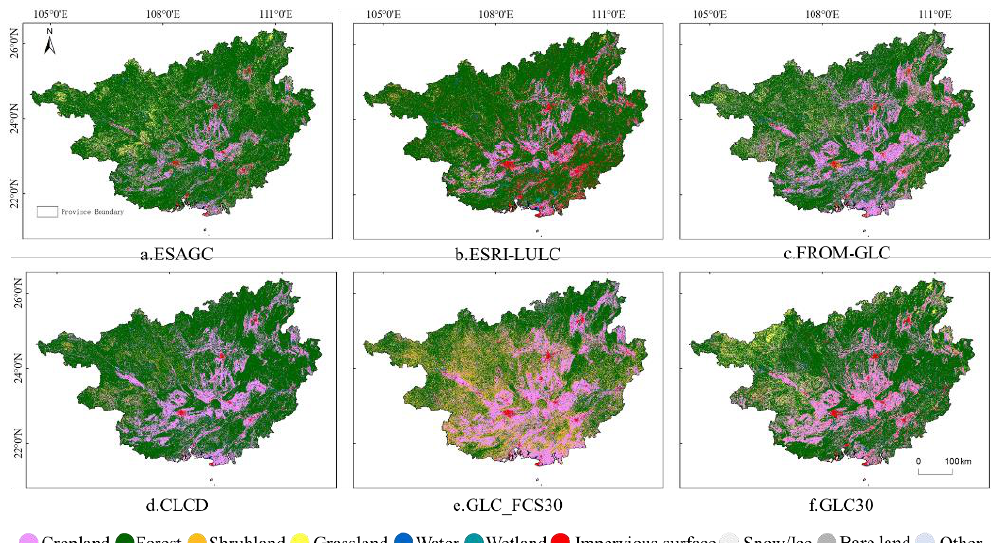
Figure 2. Map showing the spatial distribution map of land cover types in Guangxi in the different land cover products after reclassification in